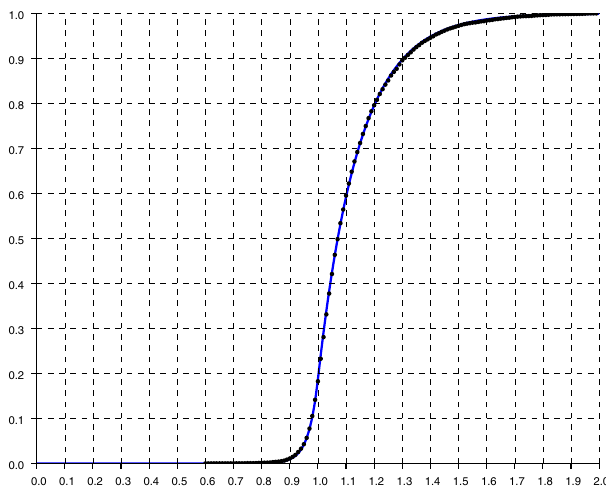
Figure 6. Normalized cumulative histogram of the ratio of reported to actual distance. The solid line is the “double exponential” parametric